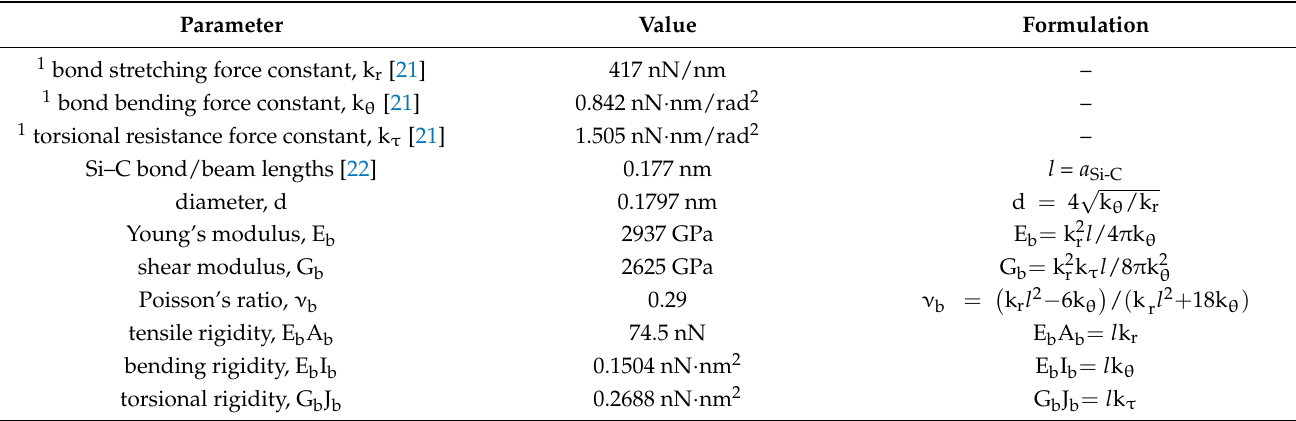
Table 1. Input parameters for FE simulations of SWSiCNTs: geometrical and mechanical properties of the beam